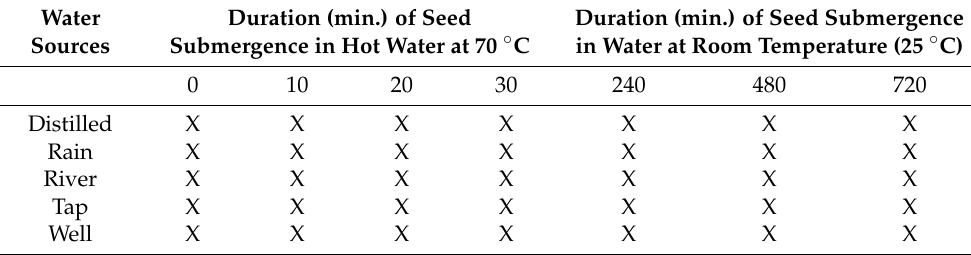
Table 2. Hydro-priming treatment